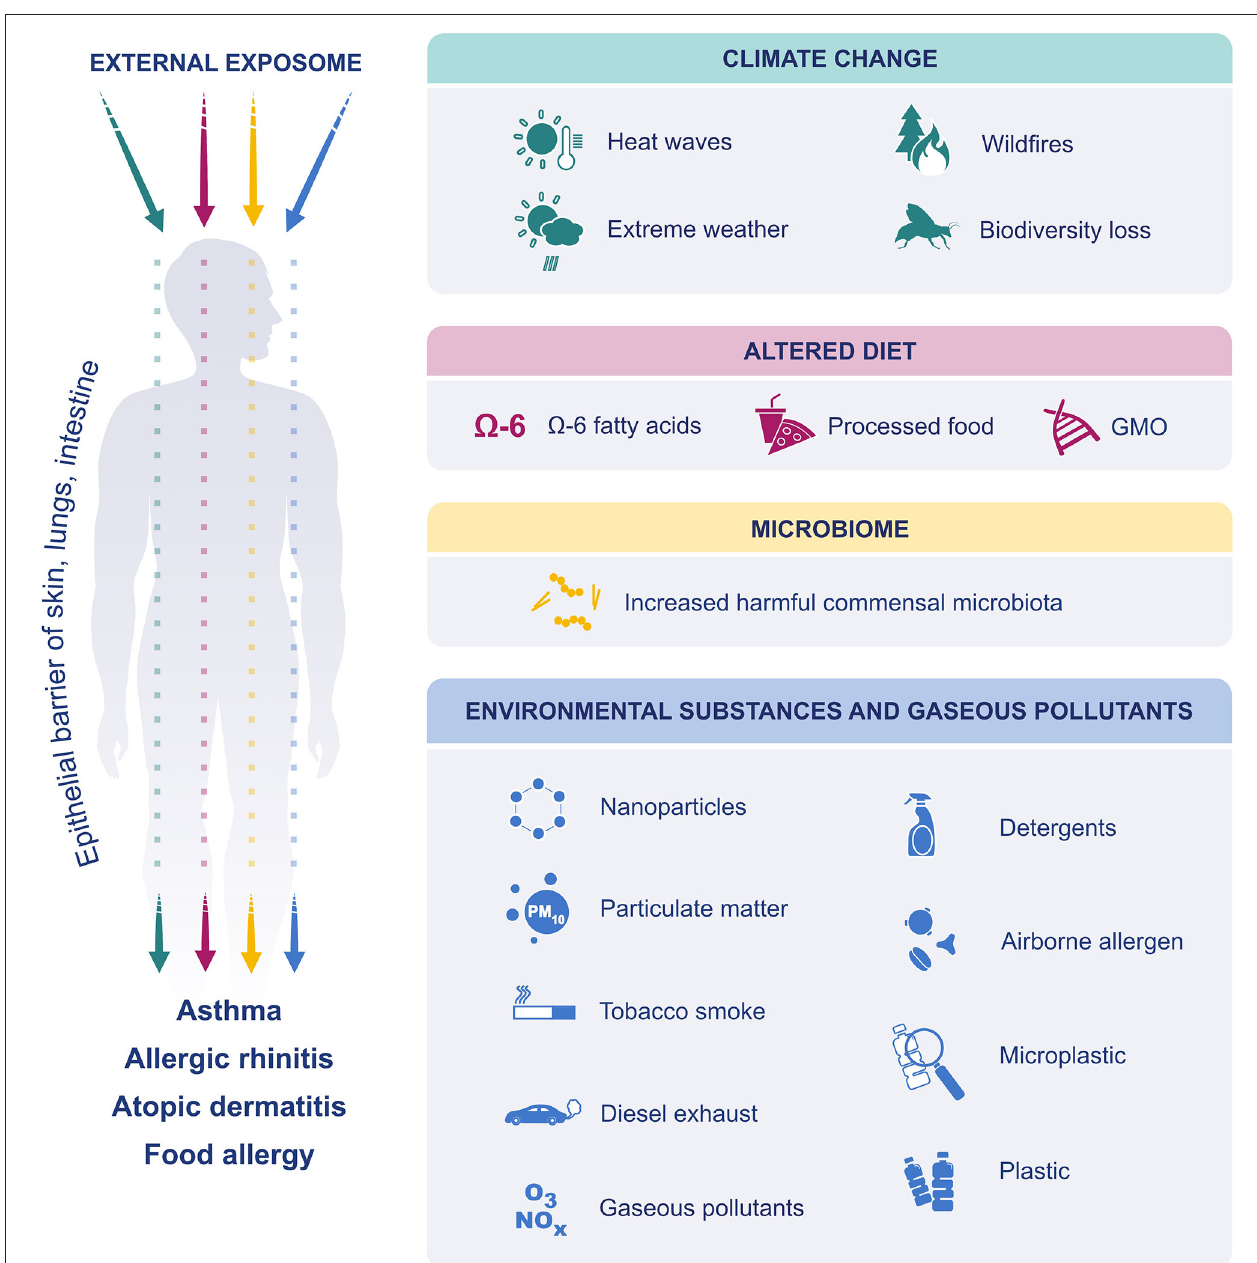
FIGURE 1 | The effect of external exposome on epithelial barriers of skin lung and intestine. Due to climate change, extreme weather events have become more frequent and more intense. The air was polluted, and biodiversity was lost. Dietary preferences have shifted toward increased consumption of processed foods, n-6 fatty acids and GM foods. Exposure to environmental substances such as, detergents, PM, ozone, diesel exhaust, nanoparticles, microplastics, environmental tobacco smoke and airborne allergens were increased. Finally, the microbiome was affected, and increase in harmful commensals resulted in dysbiosis. All these factors affect and disrupt the epithelial barriers of skin, lung and gastrointestinal system and cause allergic